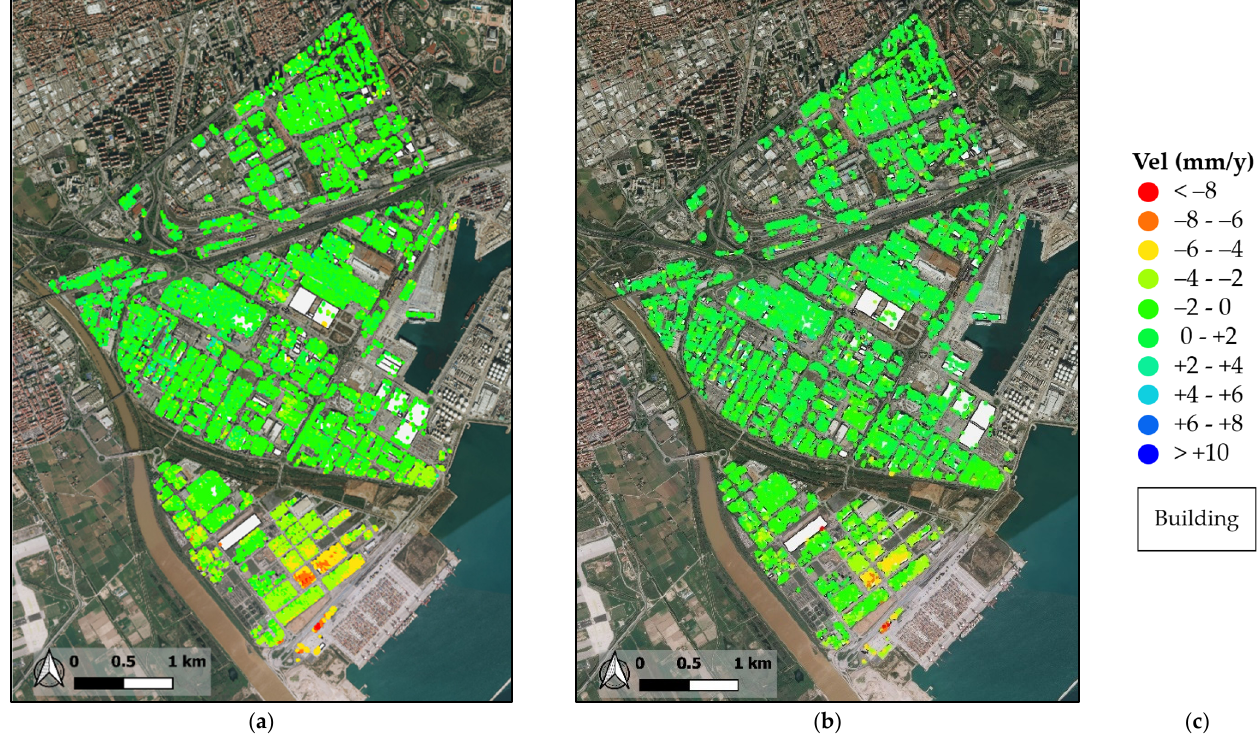
Figure 3. Distribution of the selected PSs on the buildings of the selected area of Zona Franca : ( a ) ascending and ( b ) descending. ( c ) statistics of the mean velocity V m of the selected area. Table 2. Statistics of the mean velocity V m (mm/y) of the selected area of Zona Franca .